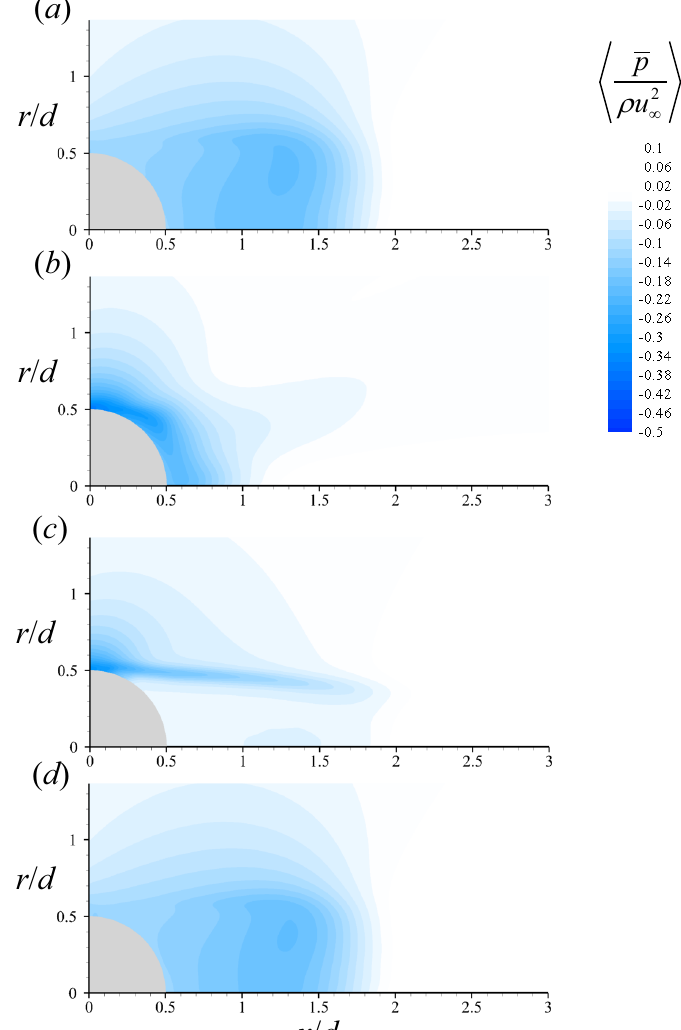
Figure 7. Contours of the averaged pressure in the near wake of the sphere with various forcing frequencies f ∗ ( V 0 / u ∞ = 0.2): ( a ) uncontrolled flow; ( b ) f ∗ = 0.25; ( c ) f ∗ = 1.5; ( d ) f ∗ = 5.0. Here, (cid:104)•(cid:105) denotes the averaging over time and azimuthal